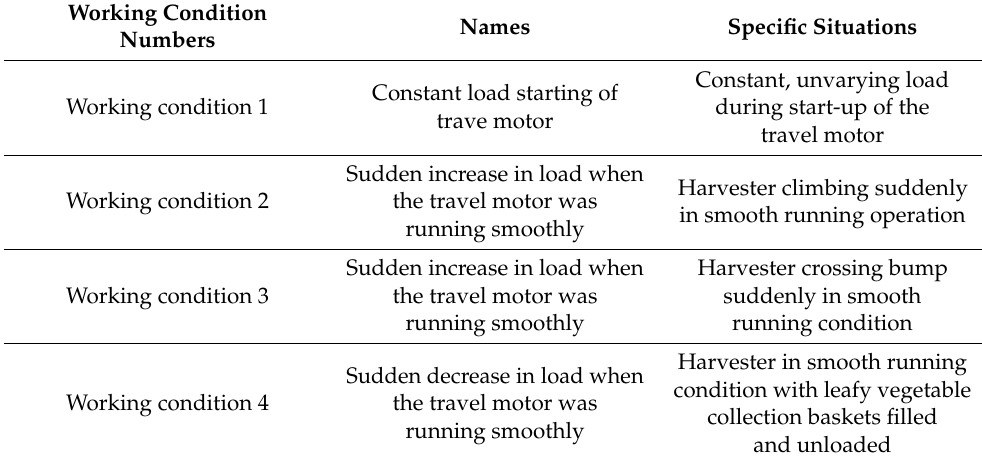
Table 4. Simulation of experimental